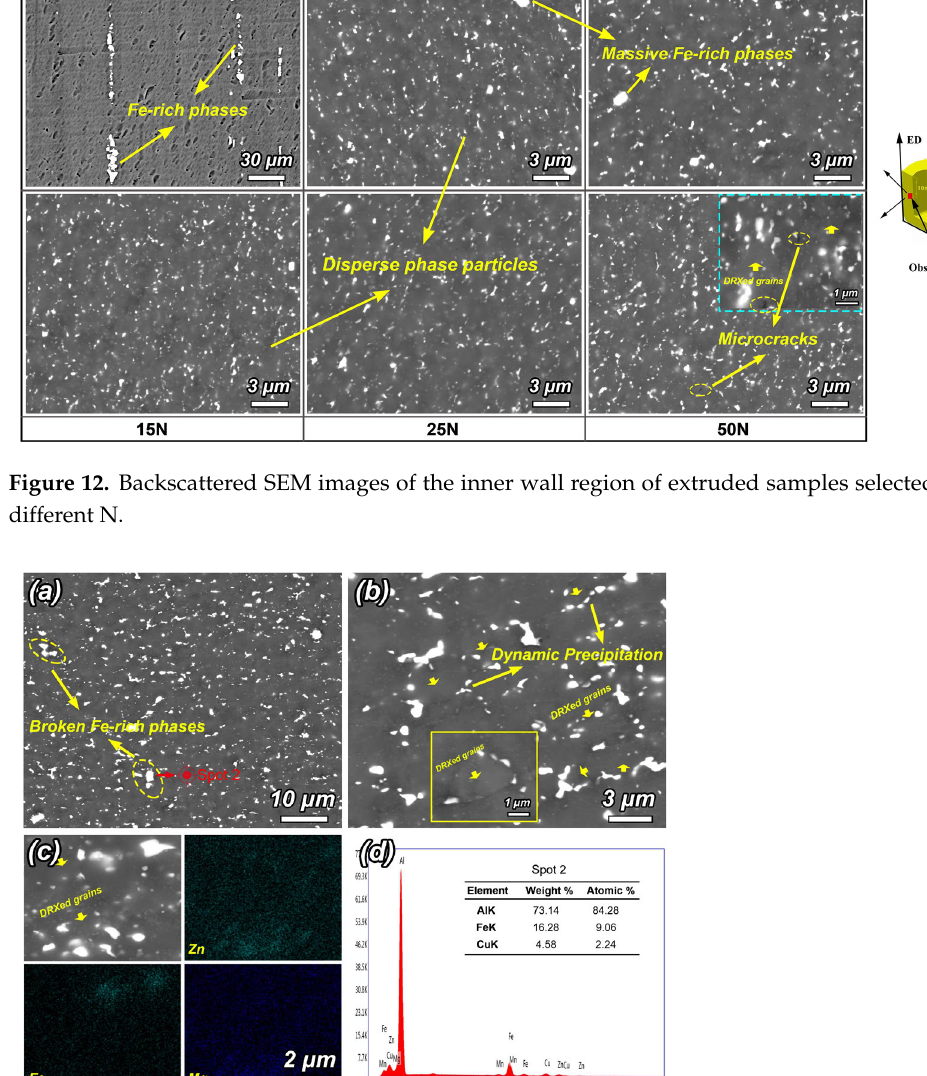
Figure 13. ( a , b ) Backscattered SEM images and ( c , d ) corresponding EDS results of the bottom de- formed region of the RBE (25 N) sample.